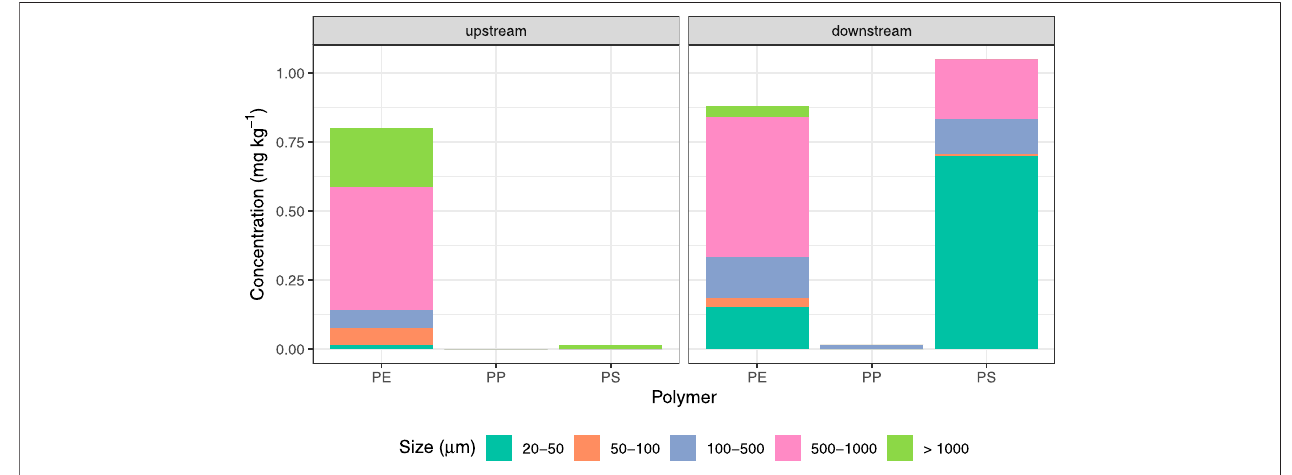
FIGURE 4 | Mass concentration of microplastics in sediment samples by polymer.